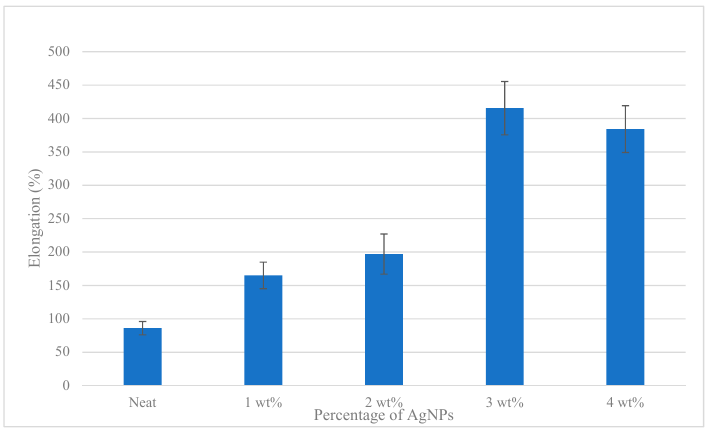
Figure 6. The effects of AgNP fillers on the elongation measurements. Figure 6. The e ff ects of AgNP fillers on the elongation measurements.